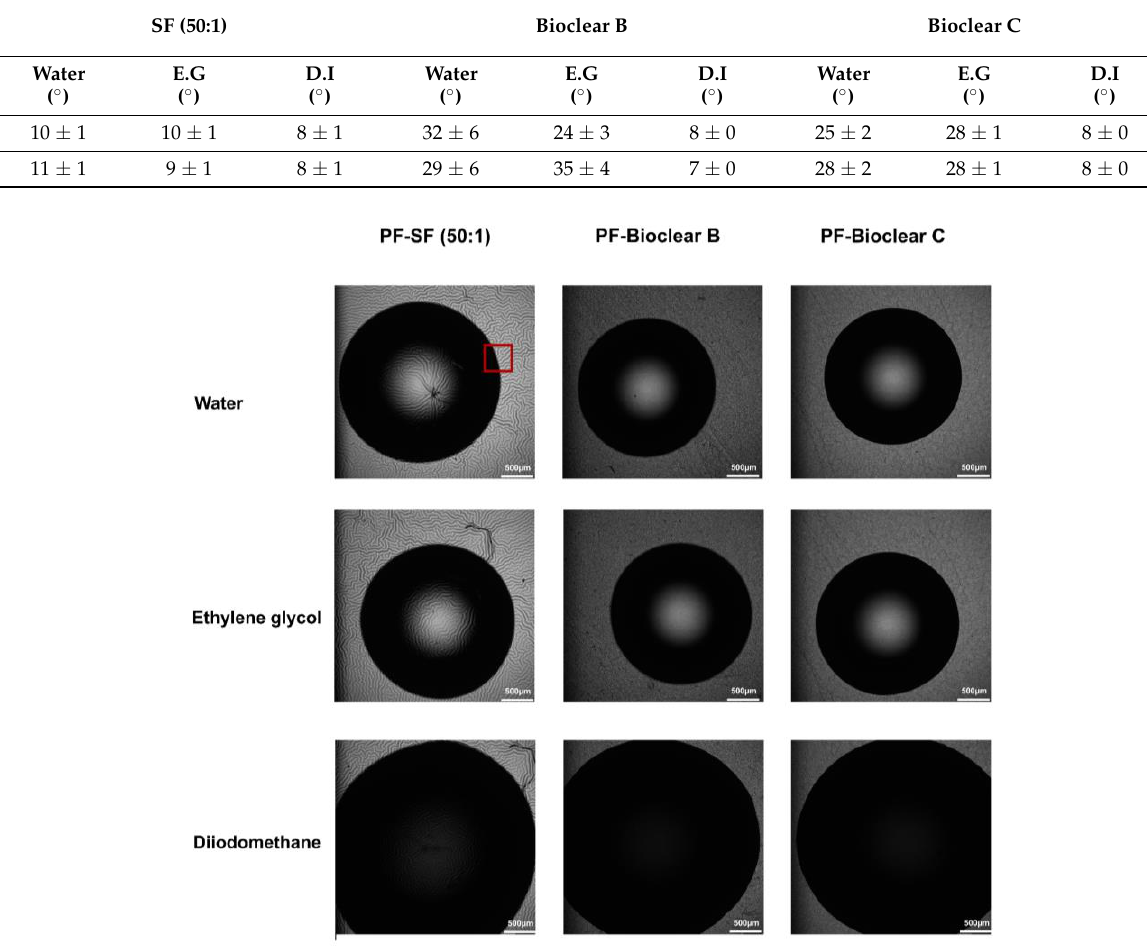
Figure A4. Brightfield microscopy images of 5µL droplets of water, ethylene glycol and diiodome- thane on the PF-PDMS surfaces. The red rectangle highlights the three-phase contact line area where the confocal microscopy images were taken in the Z-axis.